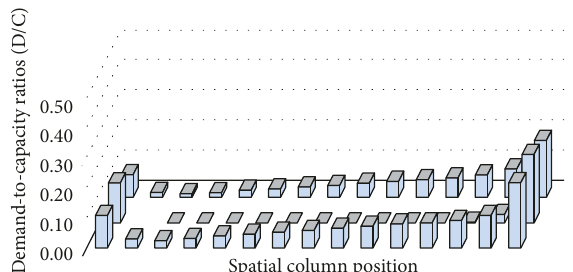
Figure 10: Demand to capacity ratios D/C: uneven distribution of inelastic response, CM placed in the actual position.